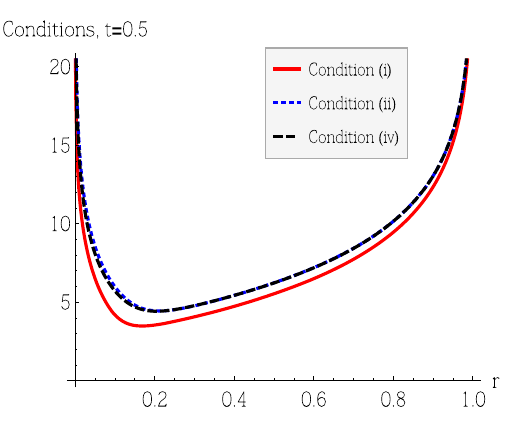
Fig. 13 Conditions (i), (ii), (iv) at t = 0 . 001